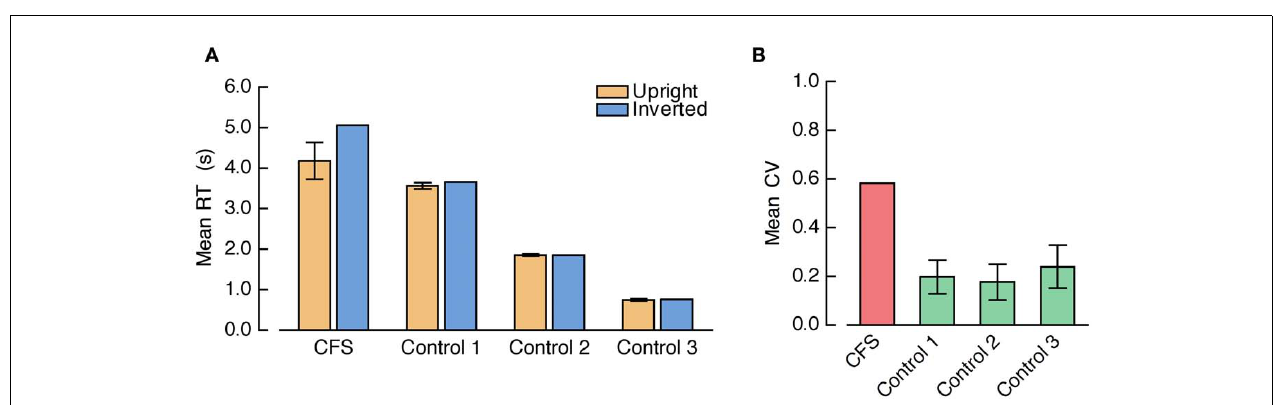
FIGURE 8 | Schematics of example trials from (A) the CFS condition and (B) the control condition in Experiments 4–6 in which we employed a new set of masks that induced longer periods of perceptual suppression in the CFS condition. In Experiments 4 and 5, we used a speeded